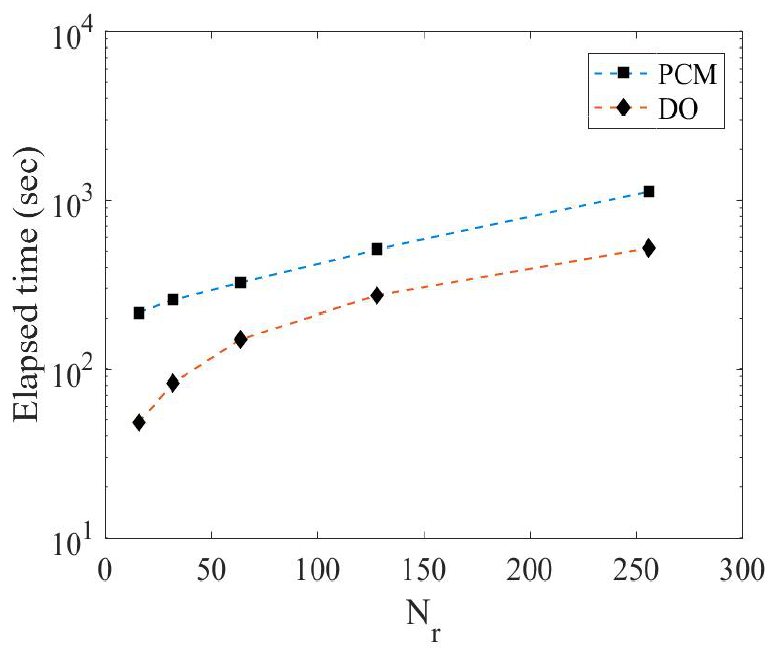
Figure 5. Burgers’ equation: The computational time against number of points (in spatial dimension) for both the PCM and DO methods.